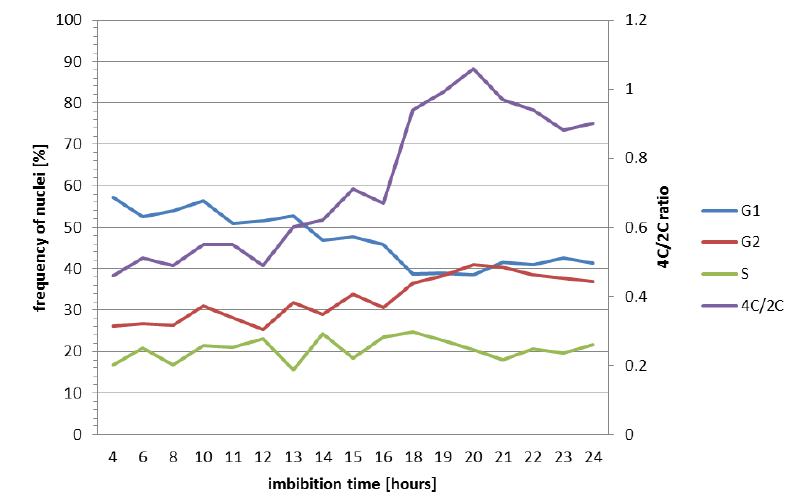
Figure 3. Percentage of nuclei in the G1, S, and G2 phases and the 4C/2C ratio in the cells from Brachypodium embryos during the first 24 h of